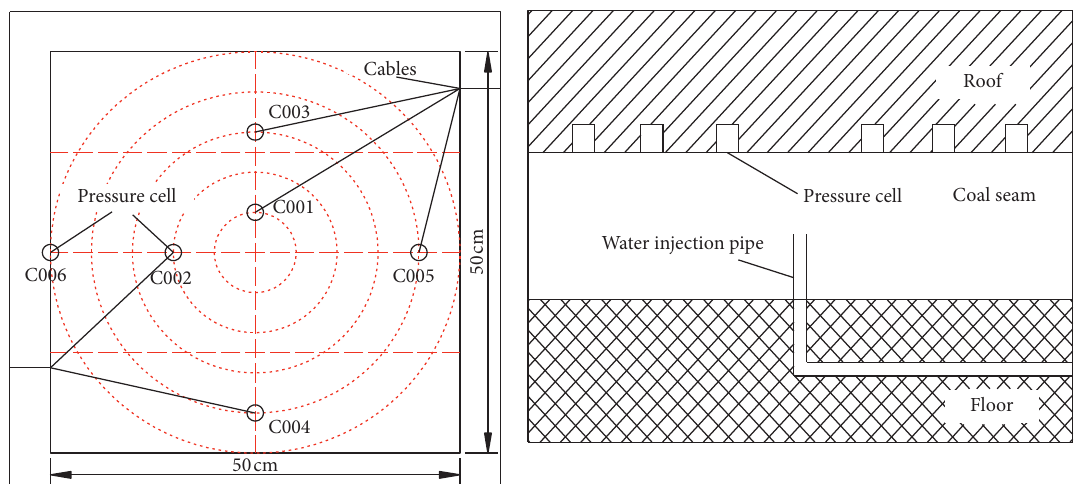
Figure 2: Arrangement of pressure cells.